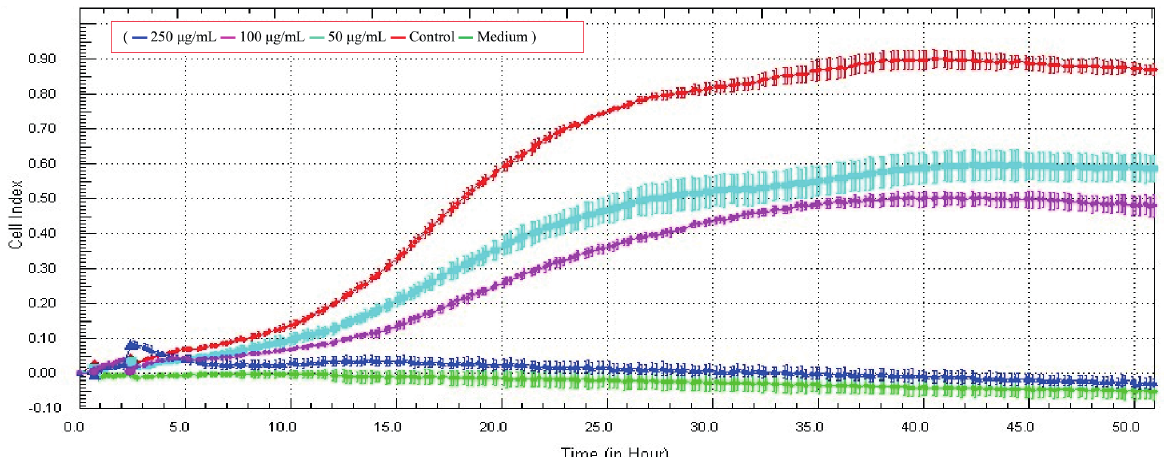
Figure 4 - In vitro antiproliferative activity of n -BuOH extract of C. sphaerocephala against Hela cell lines (2.5x10 4 cell/well). Each substance was tested twice in triplicates using RTCA xCELLigence instrument. Different concentrations of n -BuOH extract were applied to the cells represented by different color (▬ 250 μg/mL ▬ 100 μg/mL ▬ 50 μg/mL ▬ Control ▬